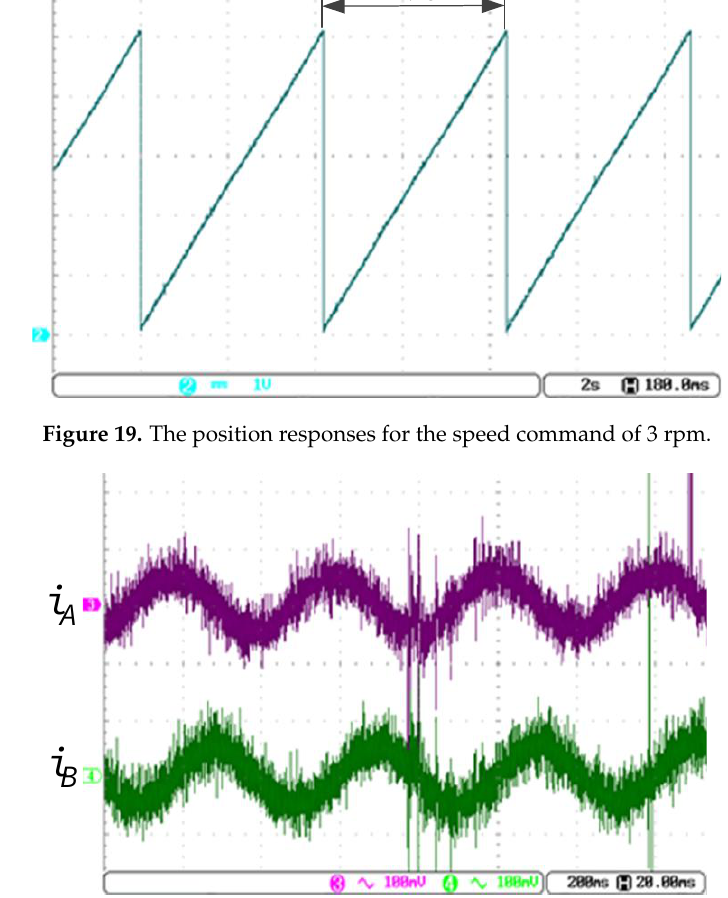
Figure 20. The current responses for the speed command of 3 rpm (185 mV/A).